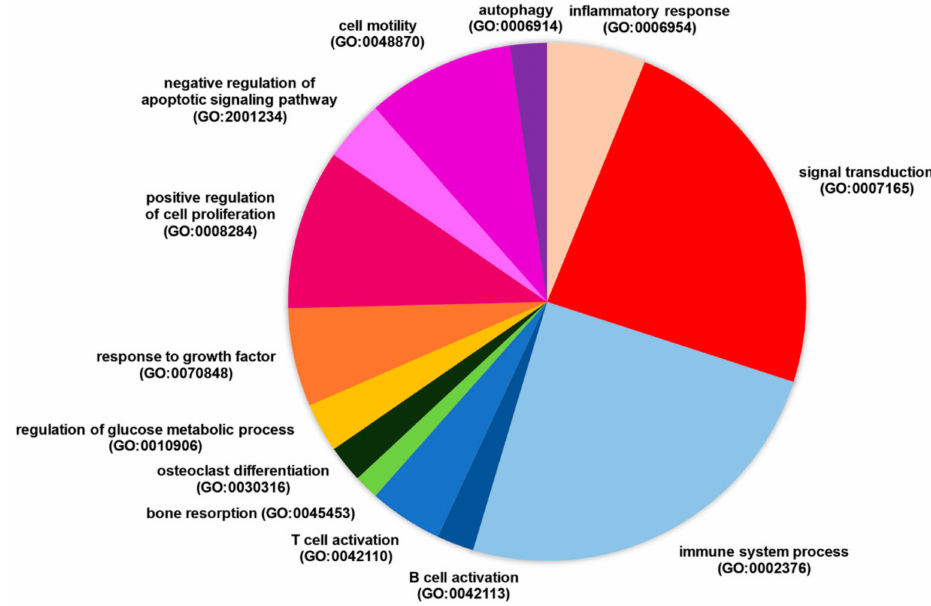
Figure 1. Biological processes involving modulated genes targeted by RP11-498C9.15 in patients with